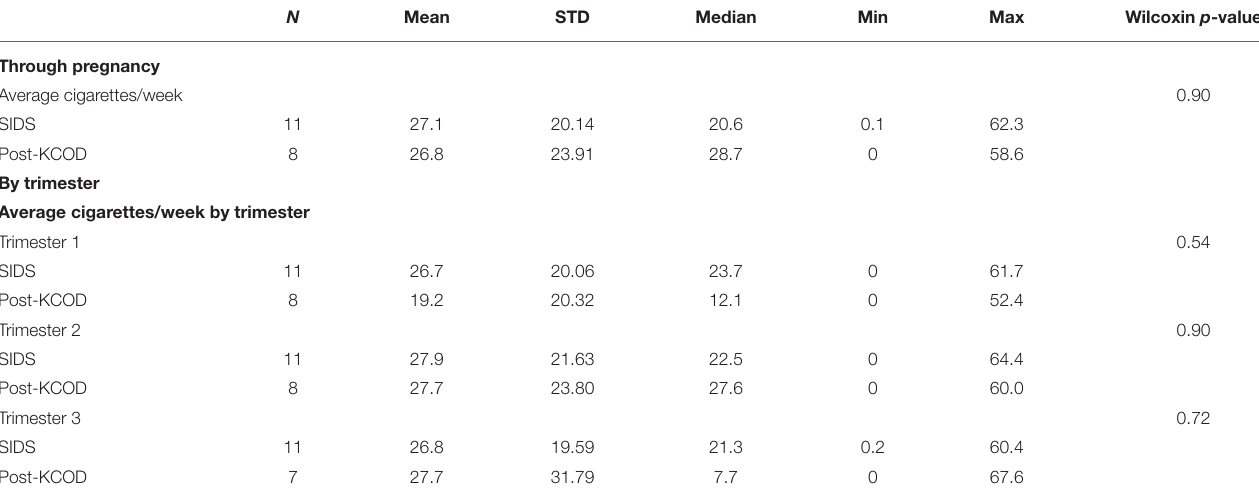
TABLE 3A | Smoking through pregnancy and by trimesters.